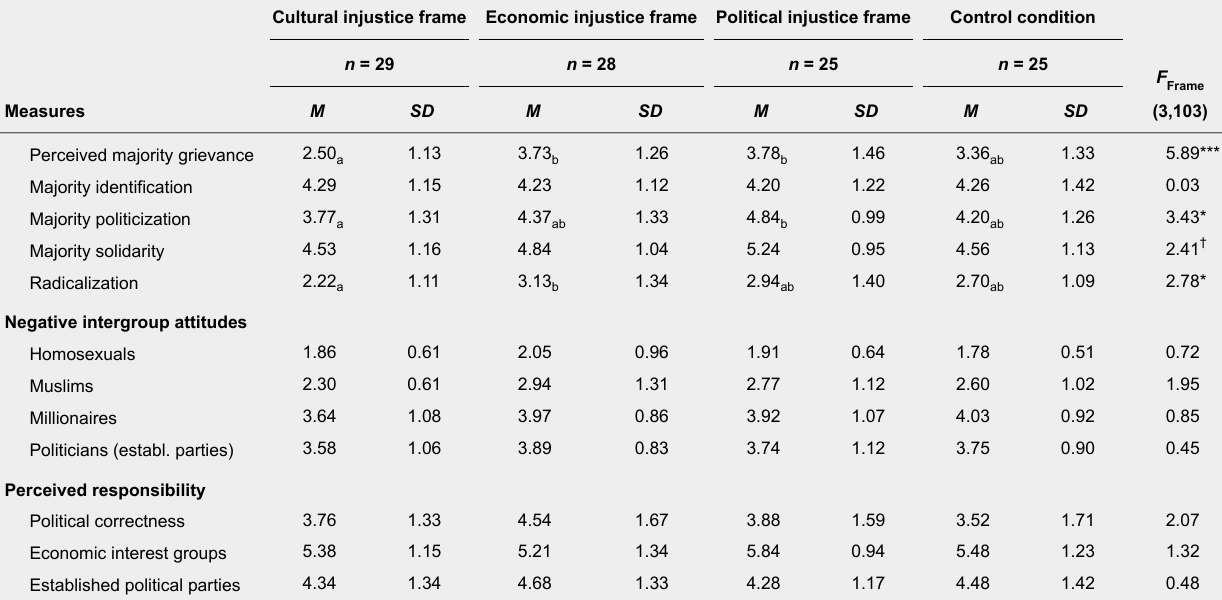
Means and Standard Deviations for the Dependent Measures (Experiment 1)